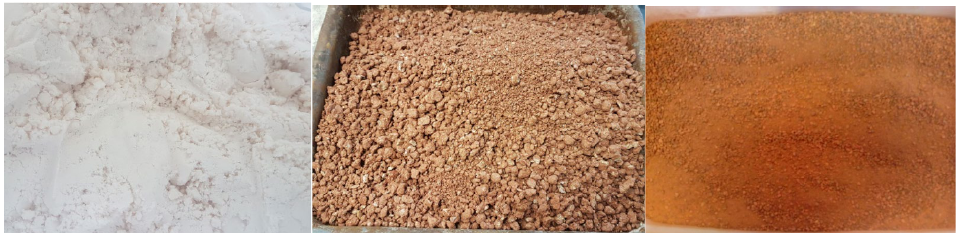
Fig. 1. Raw materials. Silica gel, unburned red clay before milling and red brick